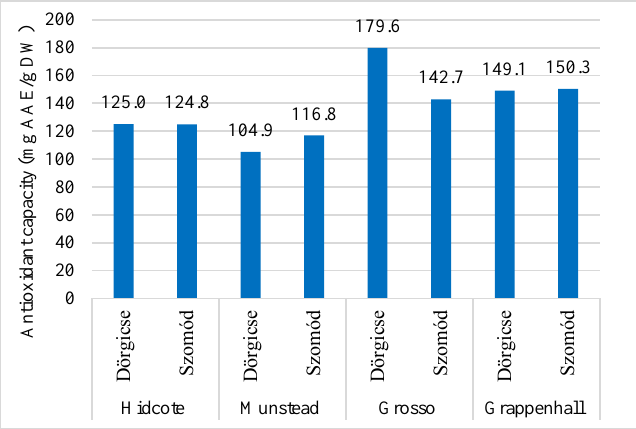
Figure 3. Antioxidant capacity (FRAP: mg AAE/g DW) of L. angustifolia and L. × intermedia cultivars in Dörgicse and Szomód (2017).